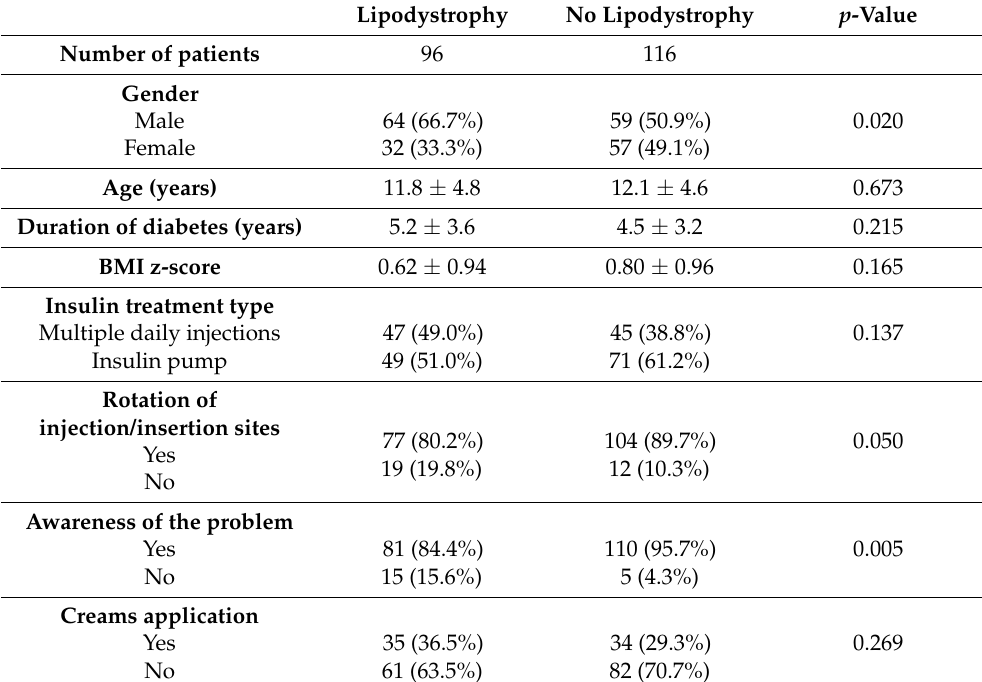
Table 2. Comparison of anthropometric and clinical data among patients with and without